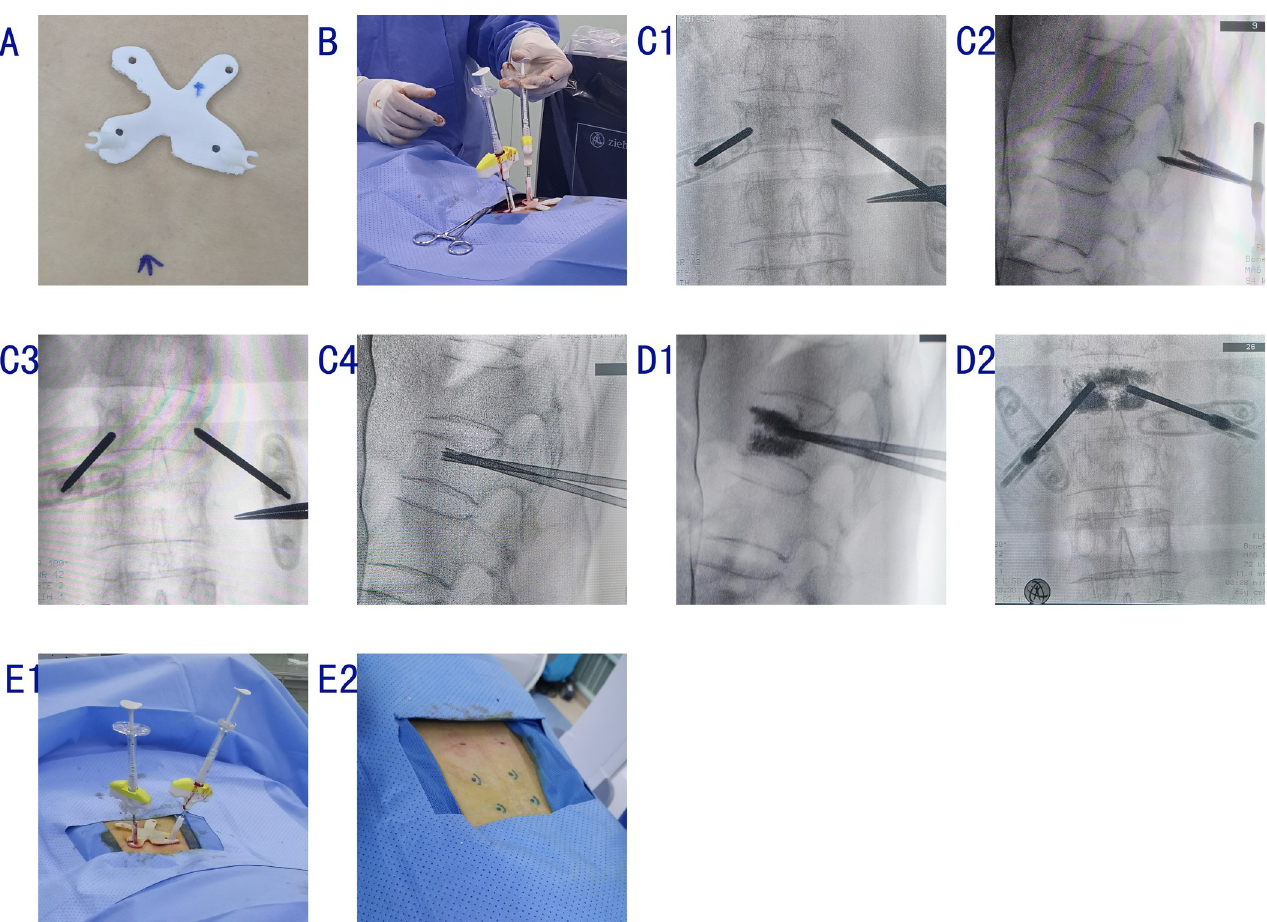
Fig 3. A : With the patient in a relaxed state, the skin was pressed against the guide and at least four holes in the guide were aligned with the skin markers. B : Guide plate to assist puncture and operation. C1 : C-arm fluoroscopy was performed to determine the correct position of the puncture needle. C2–5 : Puncture along the guide passage, with working tube placement and depth determination by fluoroscopy. D1, 2 : Bone cement was inserted with fluoroscopic guidance. E1 : The puncture needle was removed after the cement had solidified. E2 : Skin glue was used to close the skin puncture